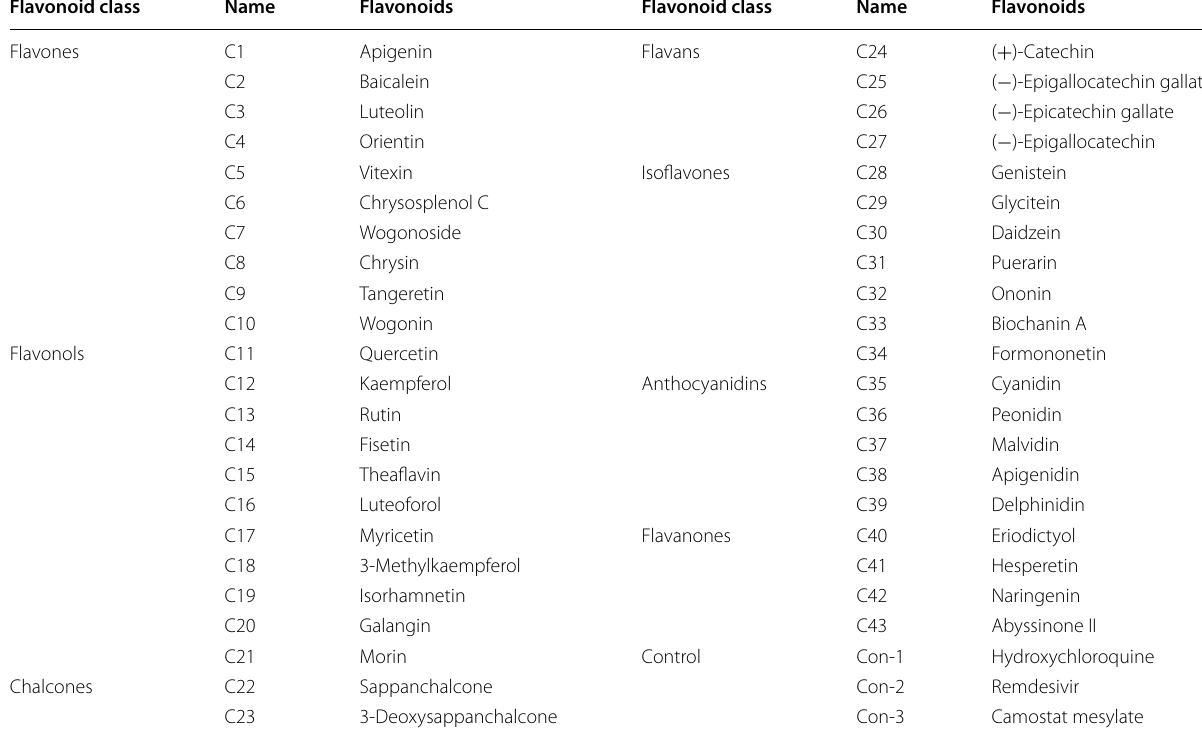
Table 1 List of selected antiviral flavonoids (phytochemicals) and drugs used as control for docking against Mpro/3CLpro, PLpro and ACE2 of COVID-19 Flavonoid